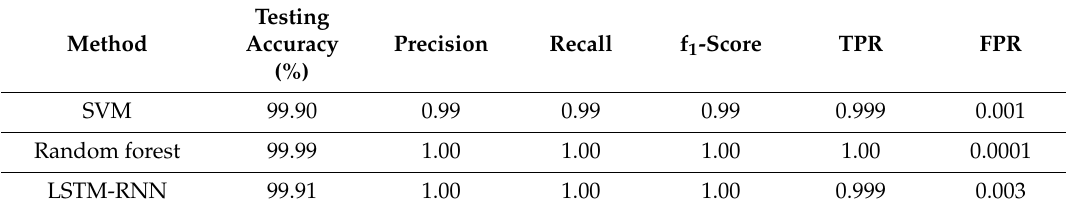
Table 12. Performance comparison for binary classification using 99 features.